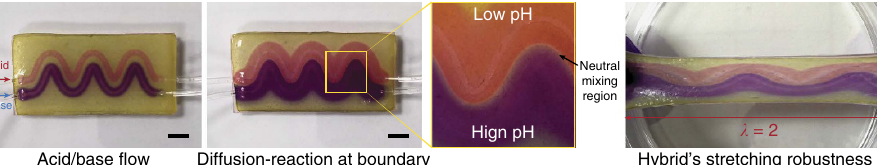
Figure 5 | Stretchable diffusive and reactive microfluidic chips based on hydrogel–elastomer hybrids. ( a ) Schematic illustration of the fabrication procedure for hydrogel–elastomer microfluidic chip. ( b ) The resultant hydrogel–elastomer microfluidic hybrid supports convection of chemicals (represented by food dye in different colours) in the microfluidic channels and diffusion of chemicals in the hydrogel. ( c ) The hydrogel–elastomer microfluidic hybrid can maintain functionality under large deformation (for example, stretch B 2) without debonding failure or leakage thanks to the robust interfacial bonding. ( d ) The hydrogel–elastomer microfluidic hybrid can be used as a platform for diffusion-reaction study. Acid (pH B 3) and base (pH B 10) solutions from two microfluidic channels diffuse in the pH-sensitive hydrogel and form regions of different colours (light red for acid and dark violet for base). The reaction of acid and base solutions in the hydrogel further form a neutral region (pH B 7, light green colour). Scale bars, 10mm ( b – d